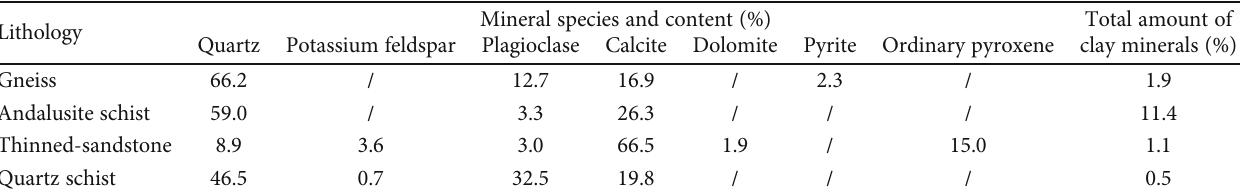
Table 2: Average spacing of the structural